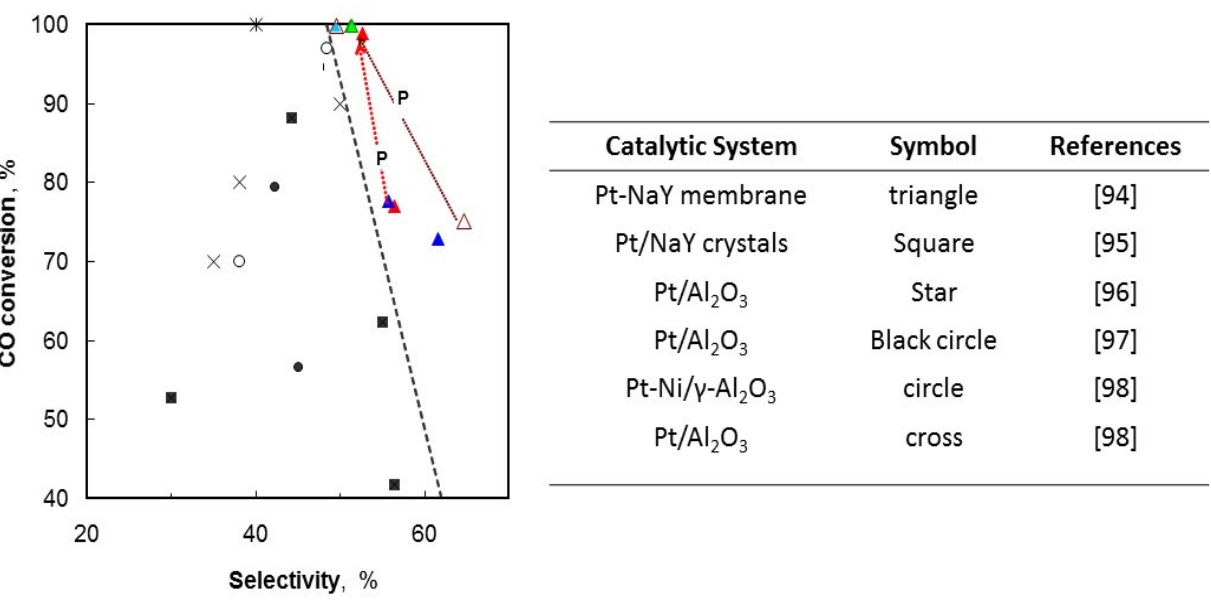
Figure 6. Ethane conversion in the membrane reactor (alumina support coated with the Mo-V-Te-Nb-Ox active phase at di ff erent stream modes: (1) co-current; (2) counter-current; operating conditions: initial fl ow rates in the membrane reactor are: 558 cm 3 /h for O 2 and 1672 cm 3 /h for C 2 H 4 (O 2 :C 2 H 6 = 1:3).